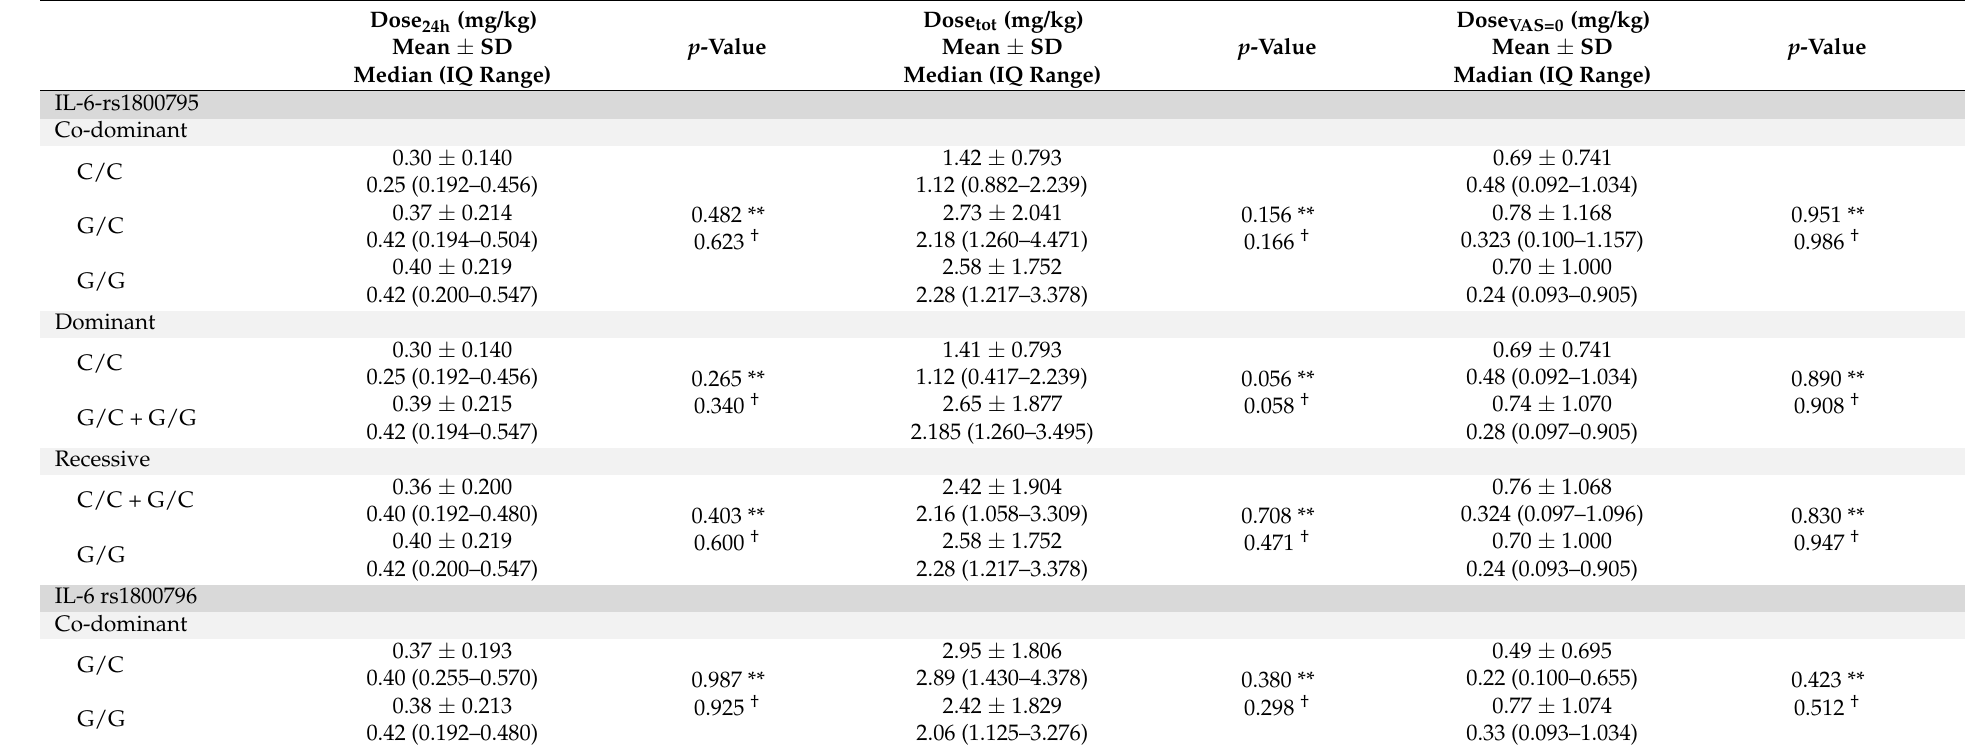
Table 4. Association between genetic factors and opioid dose